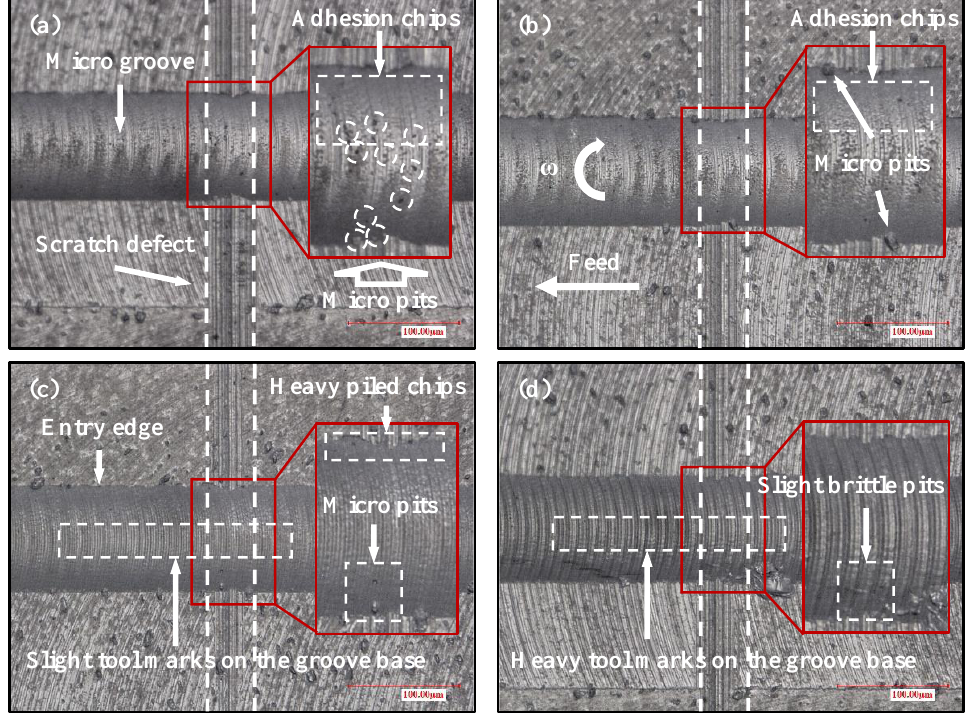
Figure 10. (Scratched surface) Machined surface topographies of microgroove with different feed rates per tooth: ( a ) f t = 0.27 µm/z, f t / r e = 0.15; ( b ) f t = 0.46 µm/z, f t / r e = 0.25; ( c ) f t = 1.37 µm/z, f t / r e = 0.75; ( d ) f t = 5.46 µm/z, f t / r e = 3.0.